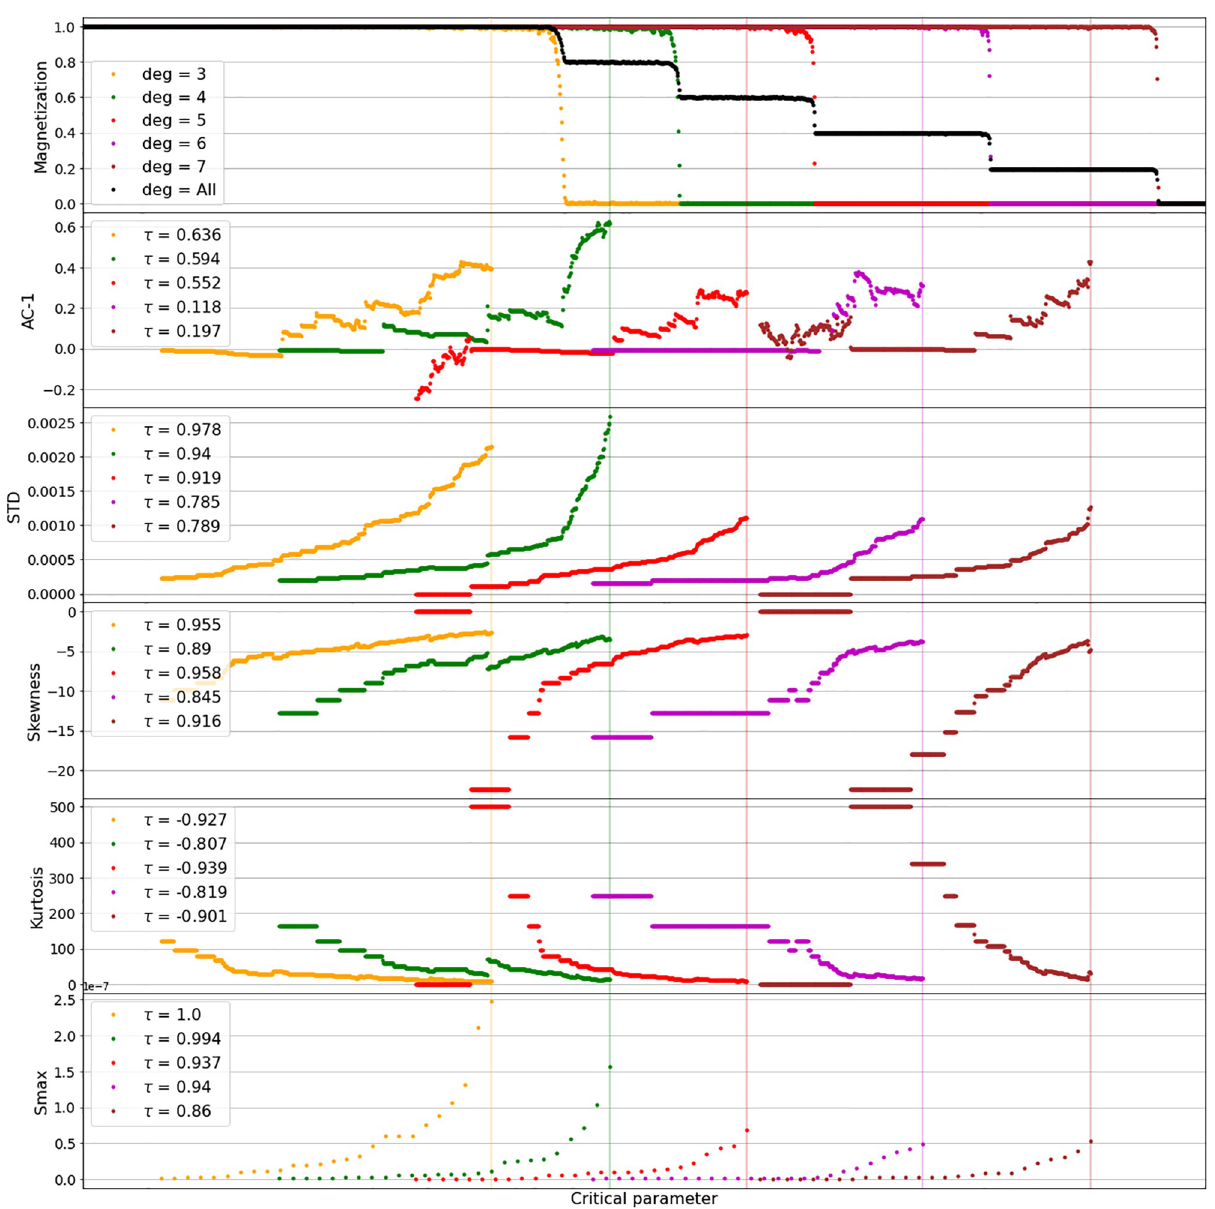
Fig 4. Early Warning Signals of networked Ising implementation as shown in Fig 3. All considered EWS-indicators meet the expected indications (AC1, STD and Smax increasing, Skewness and Kurtosis changing), with the lower degree clusters however, providing signals significantly earlier than higher degree clusters. EWS were taken on a rolling window in a distance of 100 time steps before the CT of the cluster, as indicated by the vertical lines. The legends show Kendall’s τ coefficient [28], indicating the trend of the